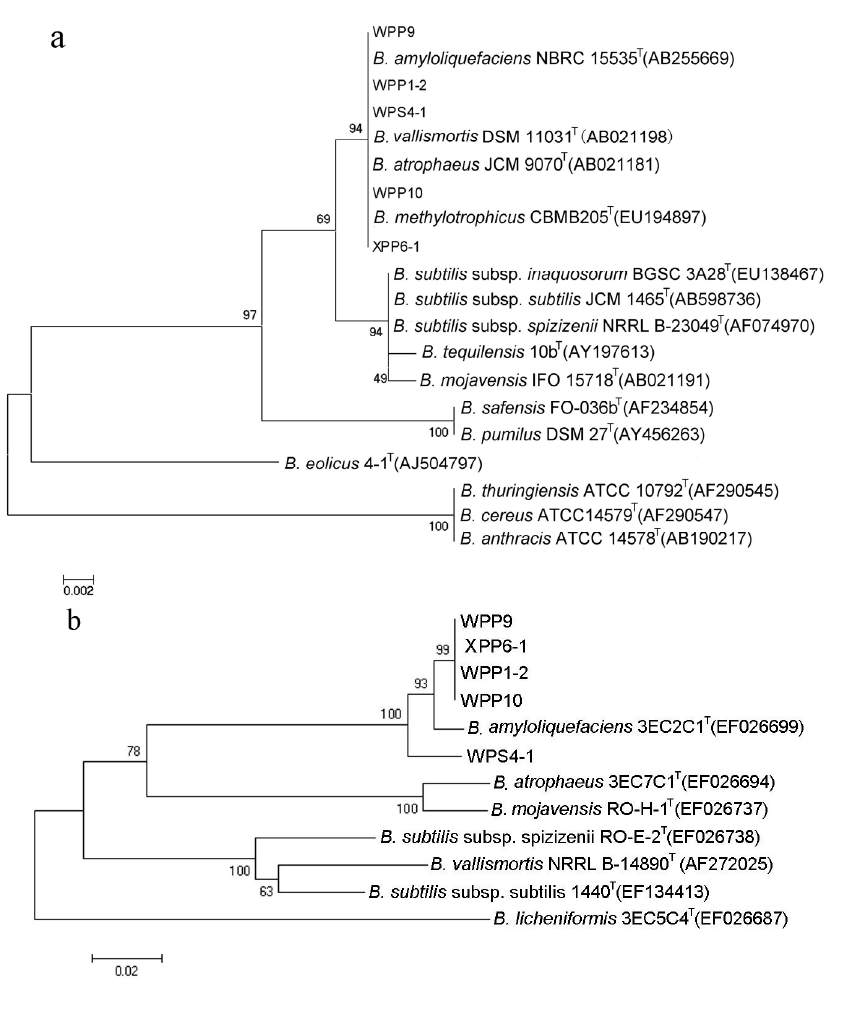
Figure 3. Phylogenetic trees of the selected five bacterial strains based on the ( a ) 16S rDNA and ( b ) gyr A gene